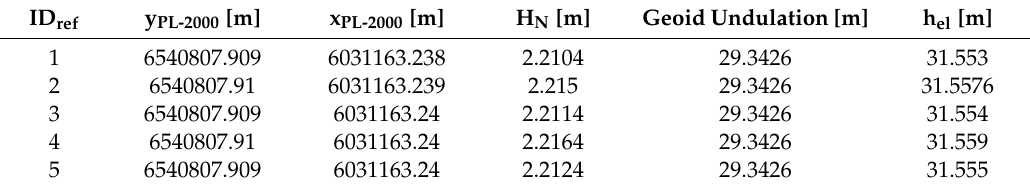
Table 3. Fragment of the input file containing satellite receiver reference